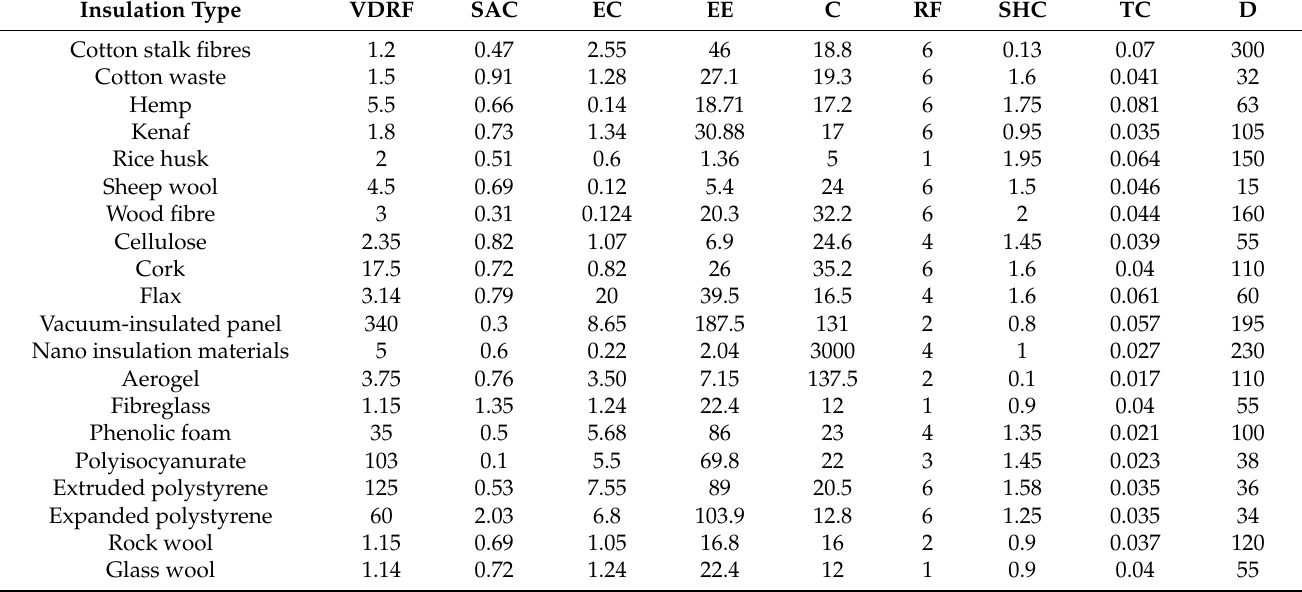
Table 5. Decision